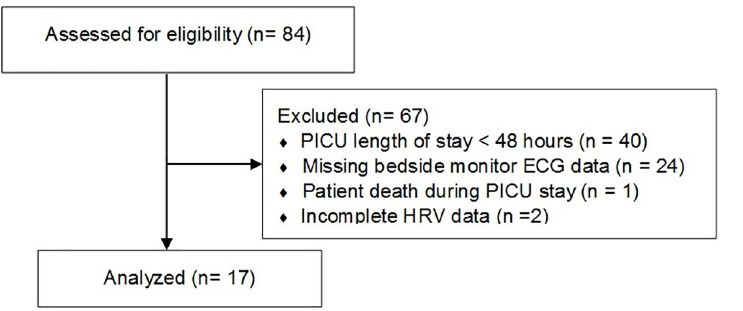
Fig 1. Cohort inclusion and exclusion flow